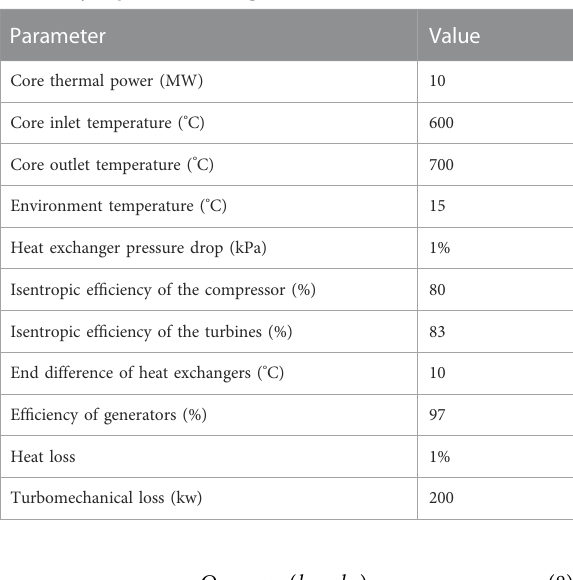
TABLE 2 Cycle parameter